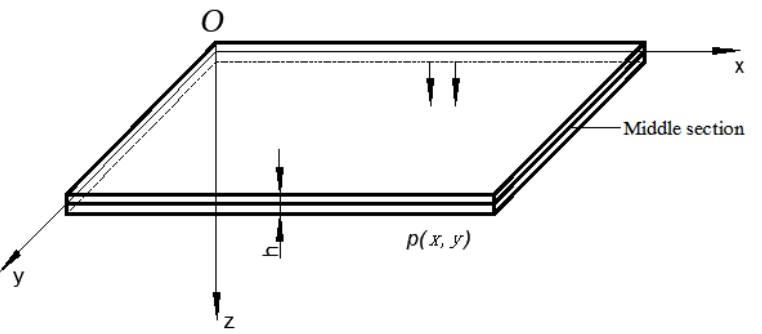
Figure 4. Middle section of a thin plate in a rectangular coordinate system.